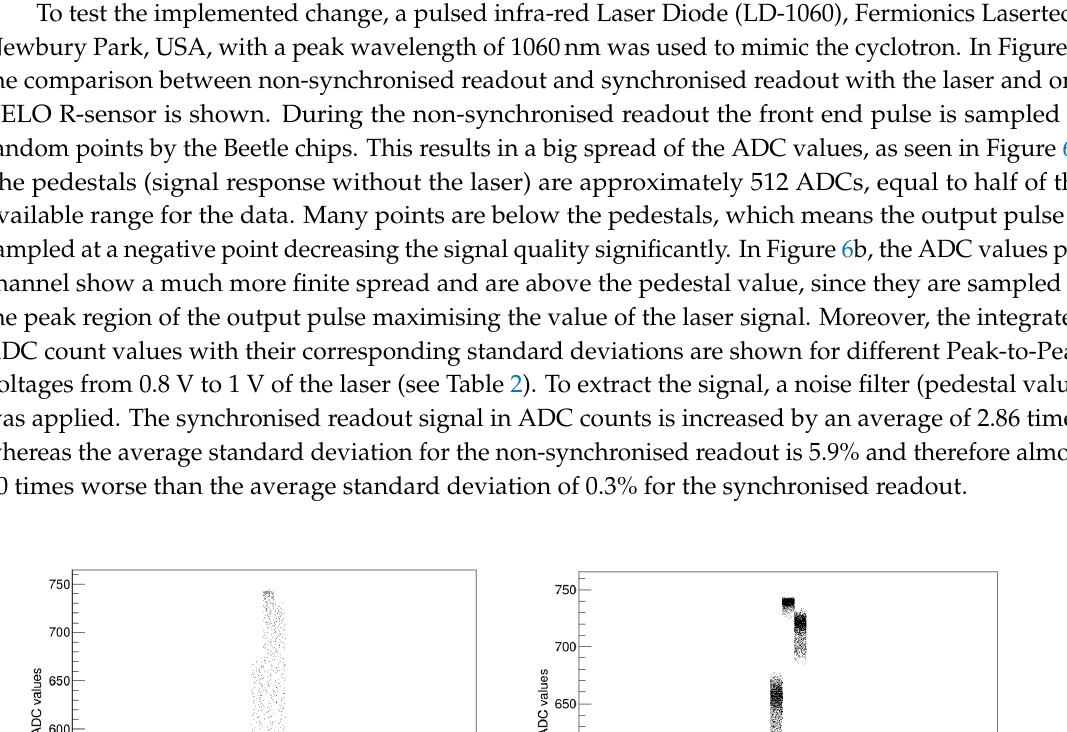
Figure 5. Introduced system to synchronise the proton bunch arrival of a medical accelerator. A readout decision is made if the rising edge of the external trigger is within the first 0–8.3 ns (detected by the 120 MHz clock) of the 40 MHz clock. Other triggers are rejected.